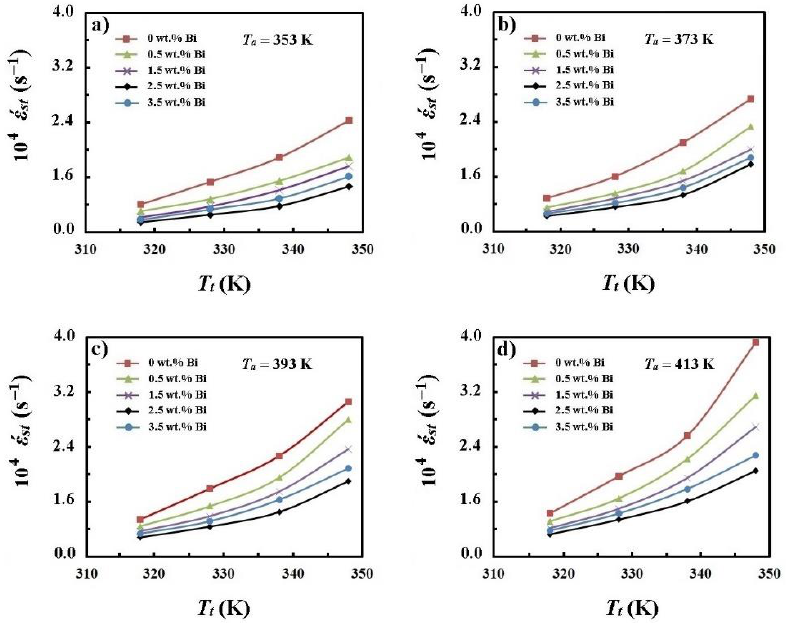
Figure 10. Dependence of steady state creep rate, έ st , on testing temperatures, T t , for different Bi contents. Aging temperatures, T a , applied are ( a ) 353, ( b ) 373, ( c ) 393, and ( d ) 413 K.